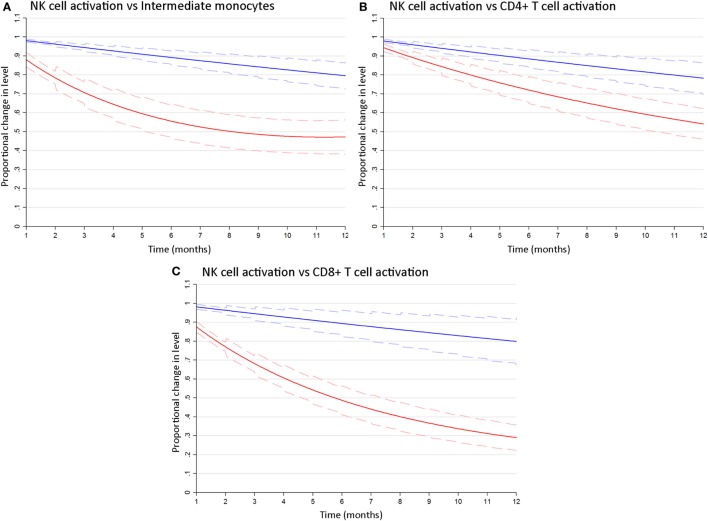
NK cell activation decays more slowly following combination antiretroviral therapy (cART) initiation than T cell or monocyte activation. Bivariate latent growth curve models comparing the modeled rate of decline in the proportion of activated CD69+ NK cells (blue lines) vs inflammatory intermediate CD14++CD16+ monocytes [red lines, (A)], activated HLA-DR+/CD38+ CD4+ [red lines, (B)] or CD8+ [red lines, (C)] T cells for 12 months after cART initiation. Mean exponentiated effects and 95% confidence intervals are shown (solid and dashed lines, respectively). Note: Plots show mean exponentiated linear/quadratic effects by time after cART initiation and 95% confidence intervals. Values <1 indicate a reduction in marker level over time.